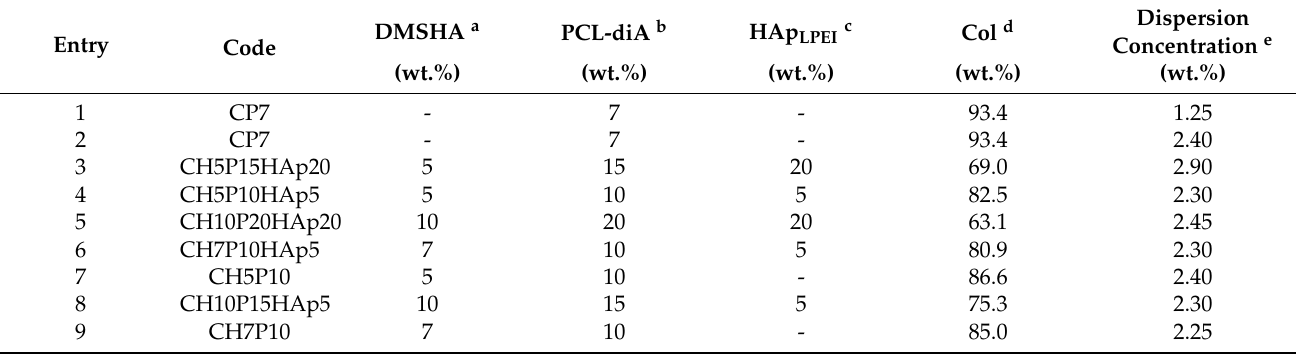
Table 1. Feed composition of the synthesized